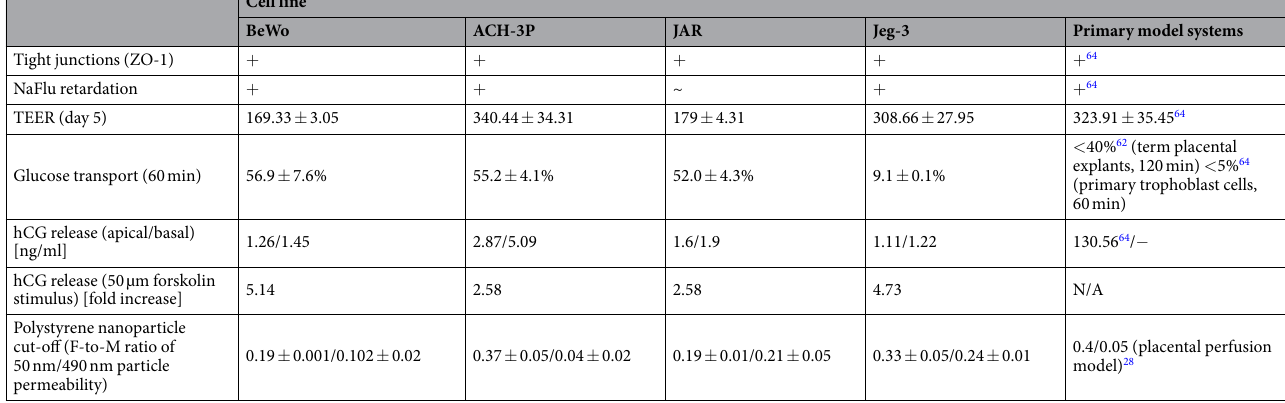
Table 1. Functional evaluation matrix for BeWo, ACH-3P, JAR and Jeg-3 cell